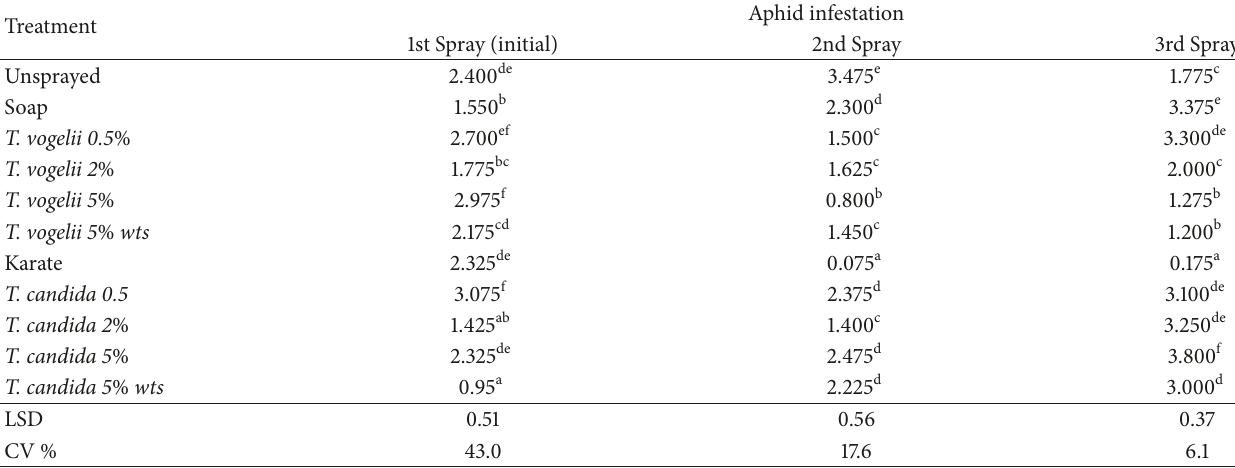
Table 2: Mean aphid infestation and abundance of two botanicals extracts at different concentrations.